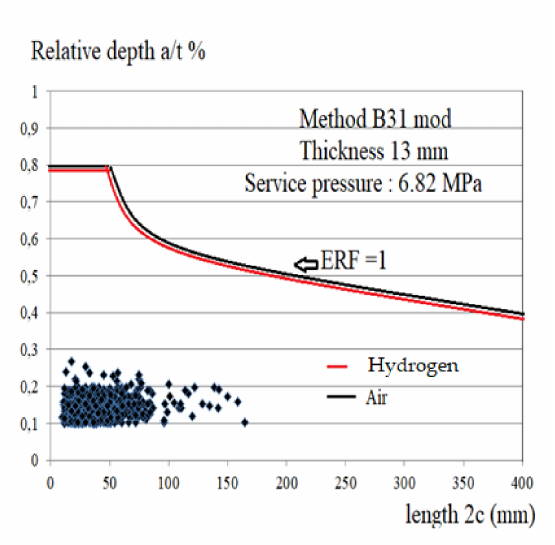
Figure 15. Relative defect depth versus defect length. Condition of repairing based on Estimated repair factor